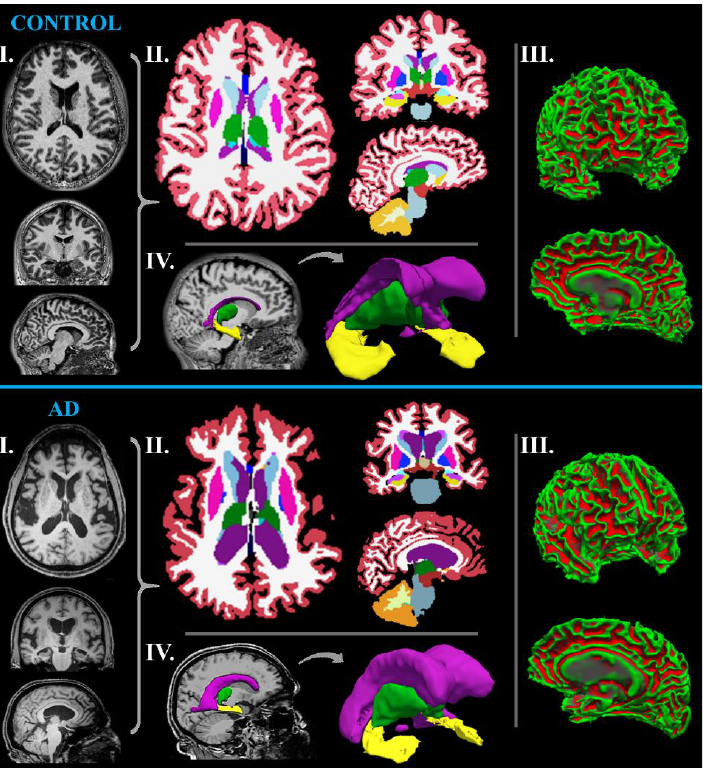
Figure 2. Example of MRI (I.; T 1 -weighted MRI at 3 Tesla MR-scanner) and MR-volumetric (II.; MR-volumetry performed on Freesurfer software) neuroimaging of a control subject (40-year-old female) and AD patient (42-year-old female) in axial, coronal, and sagittal sections. In AD, the apparent atrophy is shown across the white matter (III. 3D model of the whole brain) as well as in several brain structures (IV. 3D model of selected brain areas; atrophy of the hippocampus/yellow, atrophy of the thalamus/green, enlarged lateral